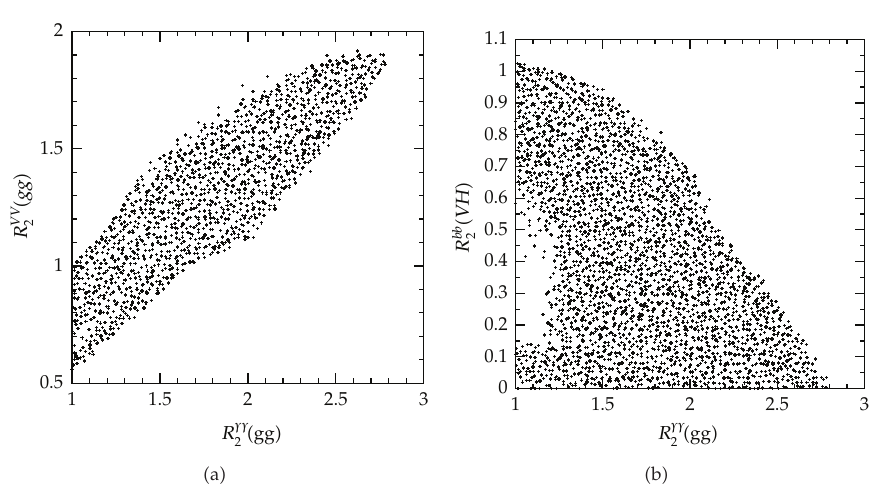
(cid:2) gg (cid:3) as function of R γγ 2 (cid:2) gg (cid:3) 2